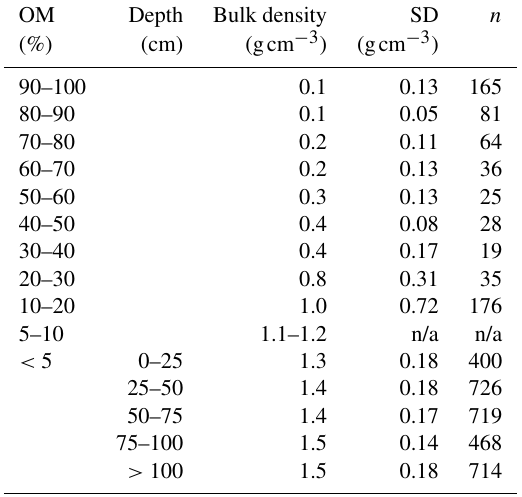
Table 1. Average bulk densities calculated from the SPADE 2 database. The mean, standard deviation and the number of obser- vations ( n ) are